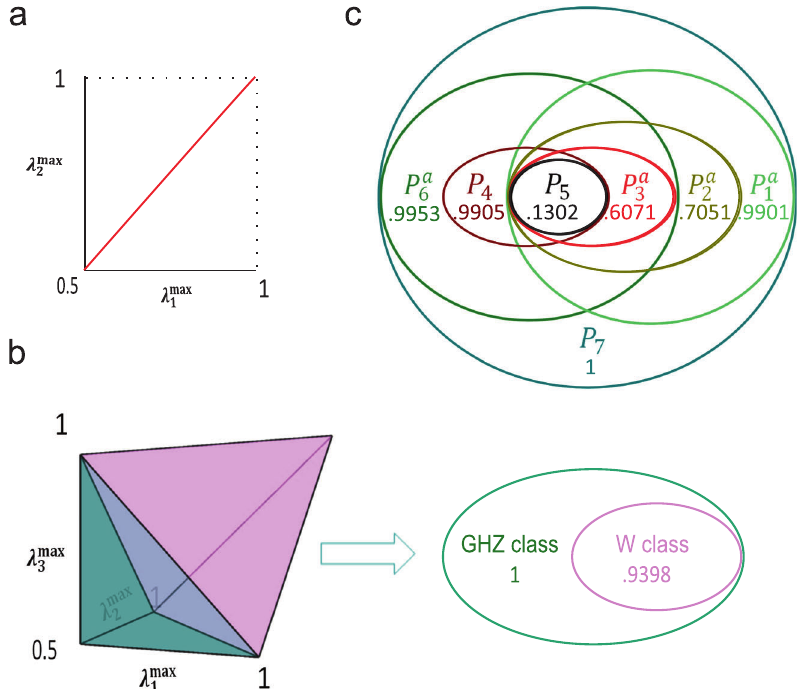
Fig. 1 N -qubit entanglement polytopes for N = 2,3,4. The coordinates λ max in a and b are given by the lager of the two eigenvalues of the i single-particle reduced density matrix of qubit i . a Two-qubit entanglement polytope (the red line ). b Three-qubit entanglement polytopes. The pink part represents the W-class, and the probability of a random state lying in this region is about 0.9398. c Nested structure of the for the various types of polytopes, we give the probability different types of four-qubit entanglement polytopes. Together with the label P m i that a random pure state lies in the that polytope (sampling 10 6 states, see Supplementary Material, Table